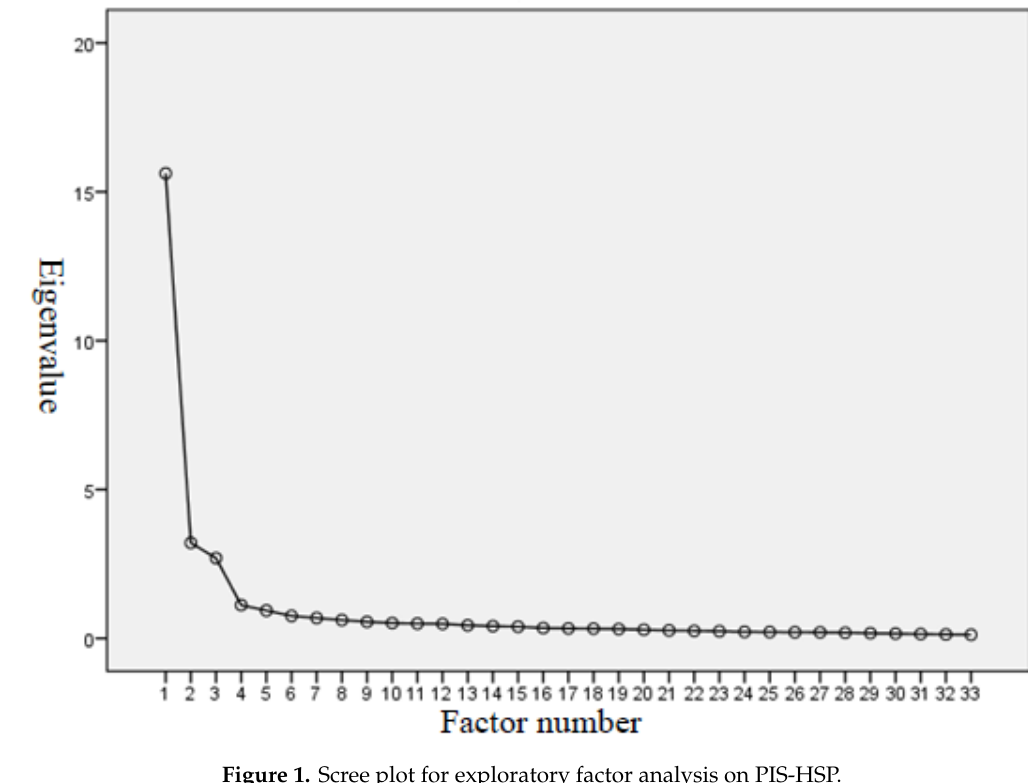
Table 2. Rotated factor loading of the EFA model for the PIS-HSP.